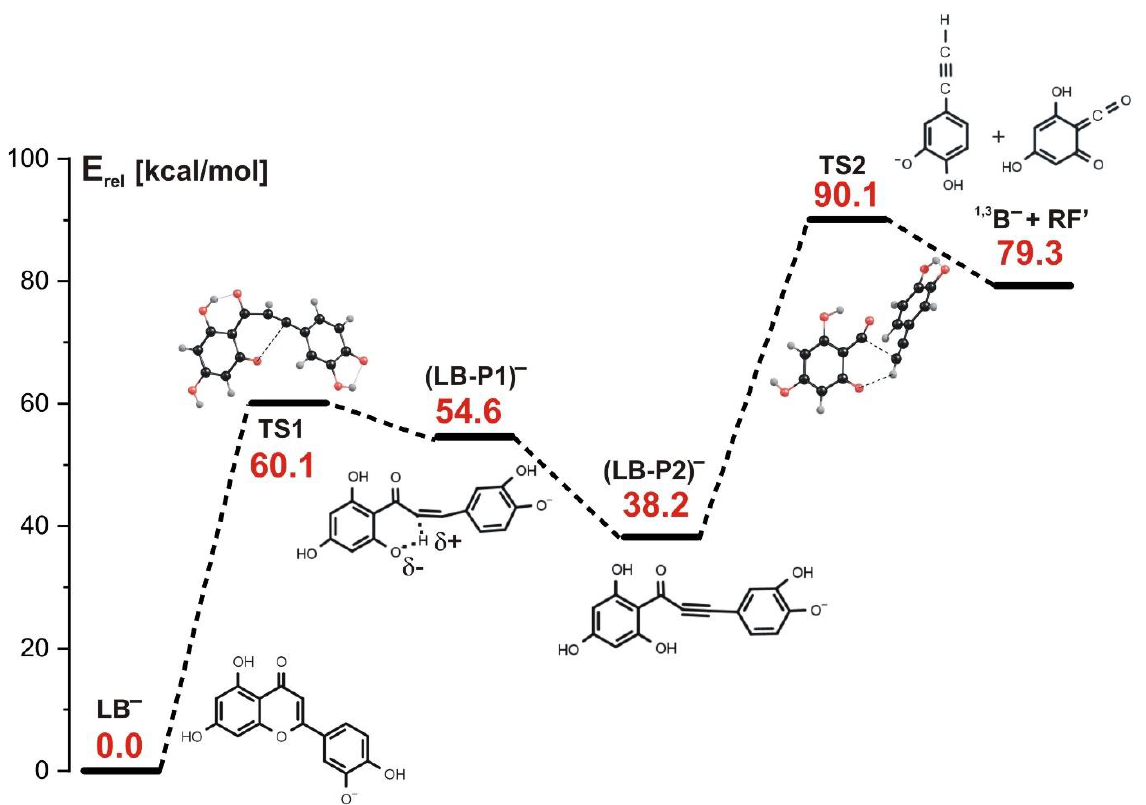
Figure 8. Energy profile for the 1,3-retrocyclization of LB - proceeding according to the stepwise mechanism and resulting in the formation of 1,3 B - negatively charged product. The energies of the transition states (TS1 and TS2), intermediate products ((LB-P1) - and (LB-P2) - ), and the separated final products ( 1,3 B - anion and the remaining neutral fragment RF’) are given (in kcal/mol) as the relative values (E rel ) with respect to the energy of the LB - substrate (taken as zero).